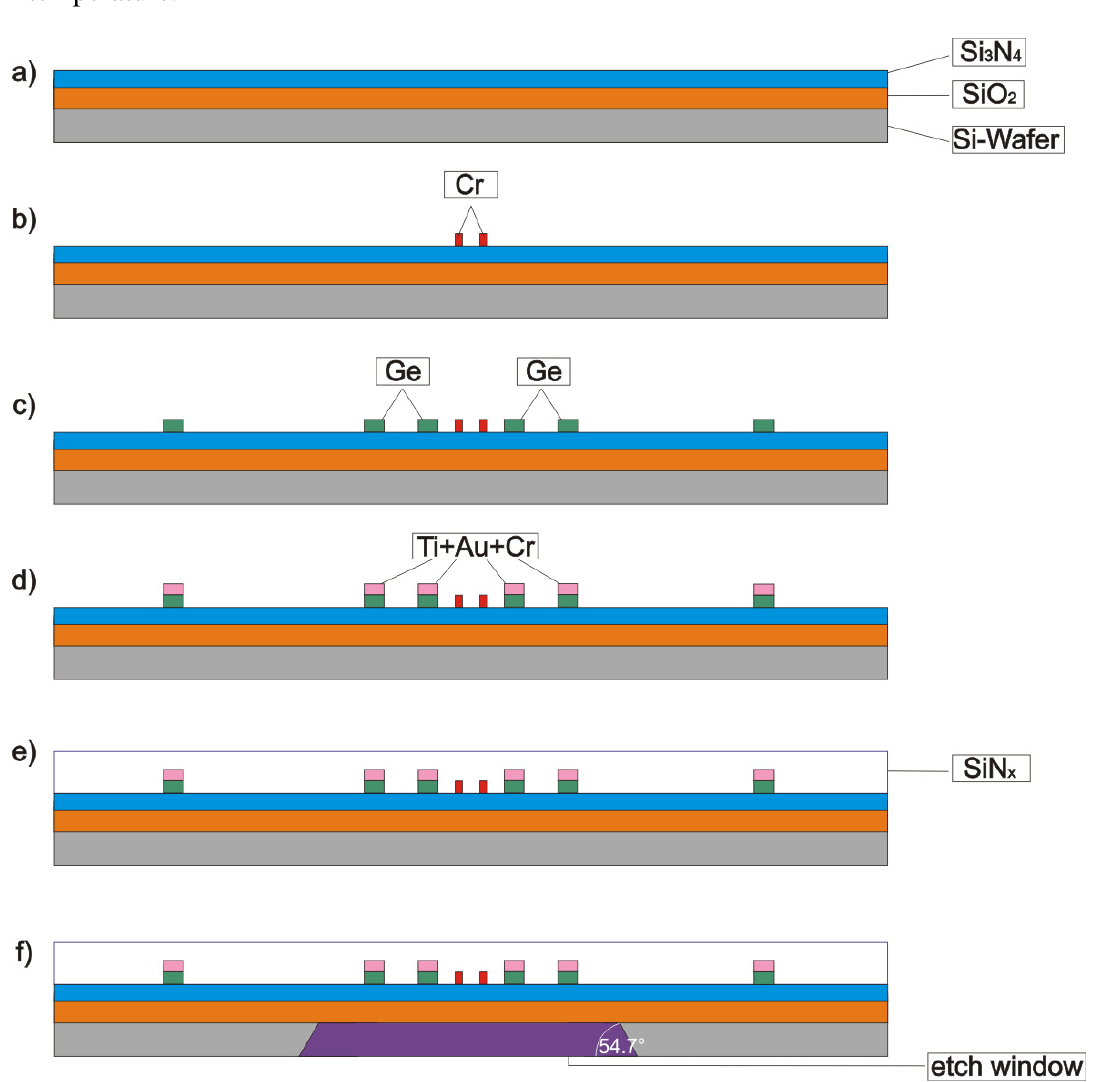
Figure 2. Sequence of main fabrication steps. Thicknesses of individual layers are not